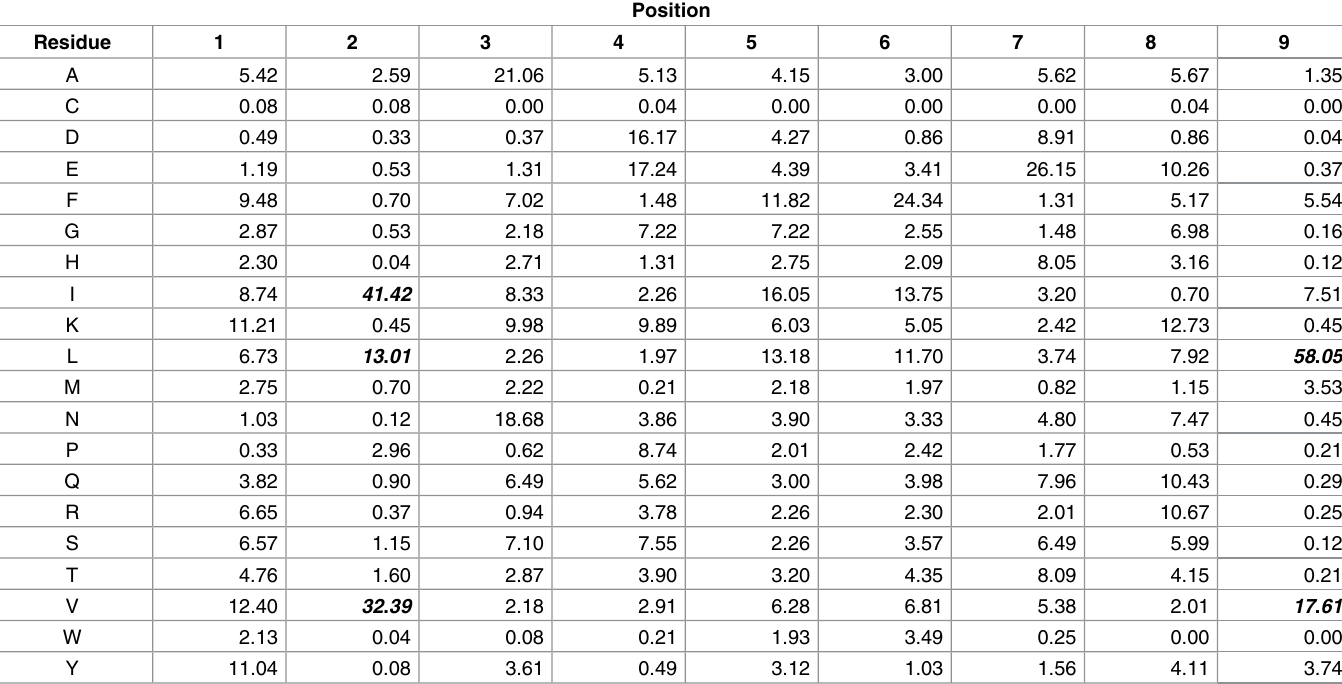
Table 2. Quantitative binding motif for DLA-88 *